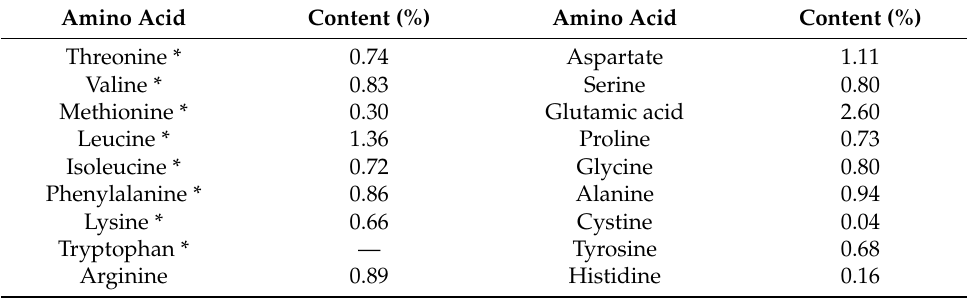
Table 3. Amino acids found in old leaves of T. sinensis .